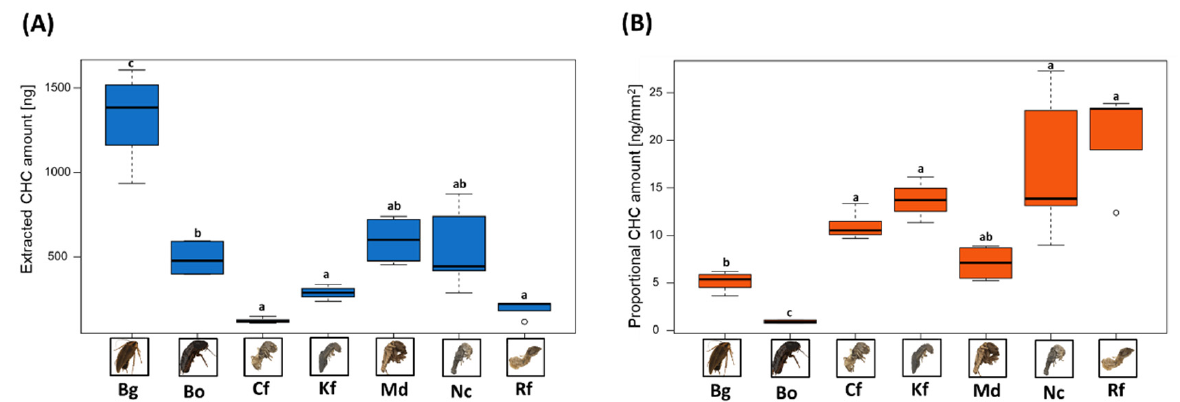
N. castaneus (Figure 3A). With around 120 ng, the termite C. formosanus yielded the lowest average CHC amount from our tested species. Conversely, when comparing CHC amounts proportional to the respective body surface areas of our study species (Table 1), different overall patterns emerge (Figure 3B).